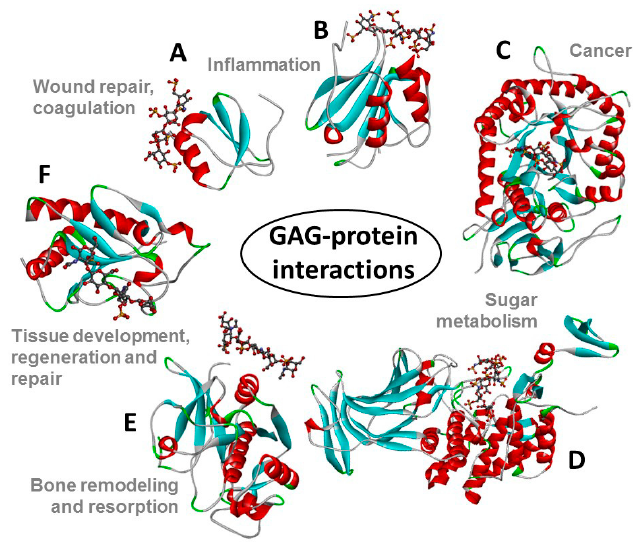
Figure 2. Structural representations from the crystal structures of some illustrative GAG-protein complexes in PDB: ( A ) macrophage inflammatory protein 1-alpha (CCL3) monomer + Hp 4-mer (from 5D65); ( B ) platelet factor 4 (CXCL4) dimer + fondaparinux (antithrombin-high affinity Hp 5-mer) (from 4R9W); ( C ) human heparanase complex + Hp tetrasaccharide (from 5E9C); ( D ) D -glucuronyl C5-epimerase + Hp 6-mer (from 4PXQ); ( E ) cathepsin K monomer + DS 6-mer (from 4N79); and ( F ) Sonic Hedgehog (Shh) monomer + CS-A 4-mer (from 4C4M). The atoms of the GAG ligands represented in the ball-stick view are carbon (grey), nitrogen (blue), hydrogen (light grey); oxygen (red) and sulfur (yellow). In the proteins, the alpha-helices, beta-sheets, loops, and random coils are represented, respectively, in red, blue, green and grey. The pathophysiological systems in which these complexes play a role are indicated by grey fonts in the